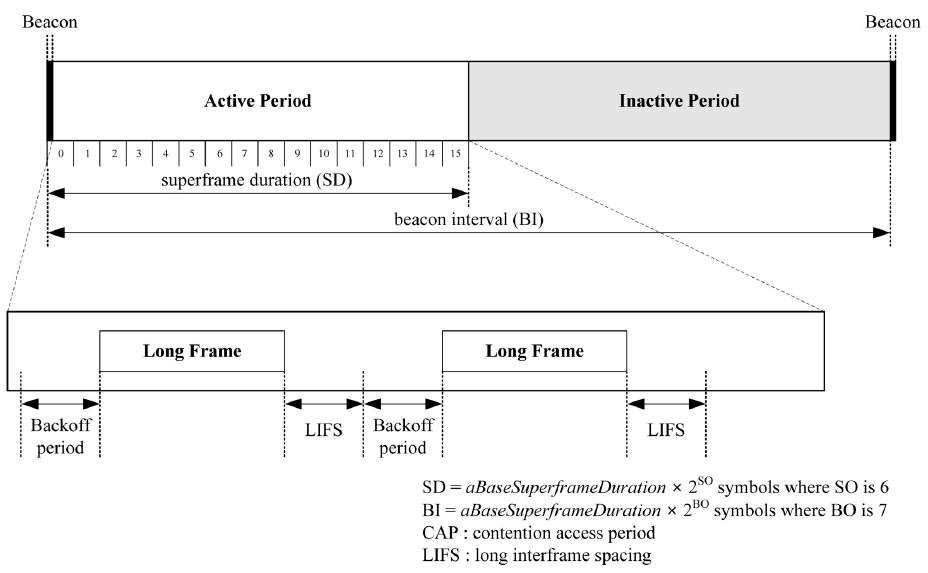
Figure 10. The structure of IEEE 802.15.4 superframe in the performance evaluation.